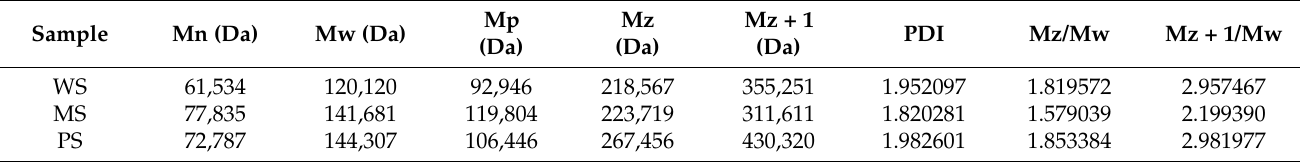
Table 1. Molecular weights and polydispersity indices (PDIs) of different starch